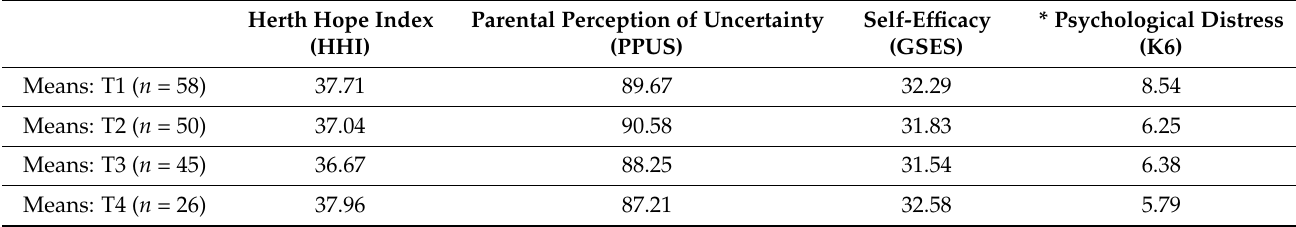
Table 3. Comparison of the